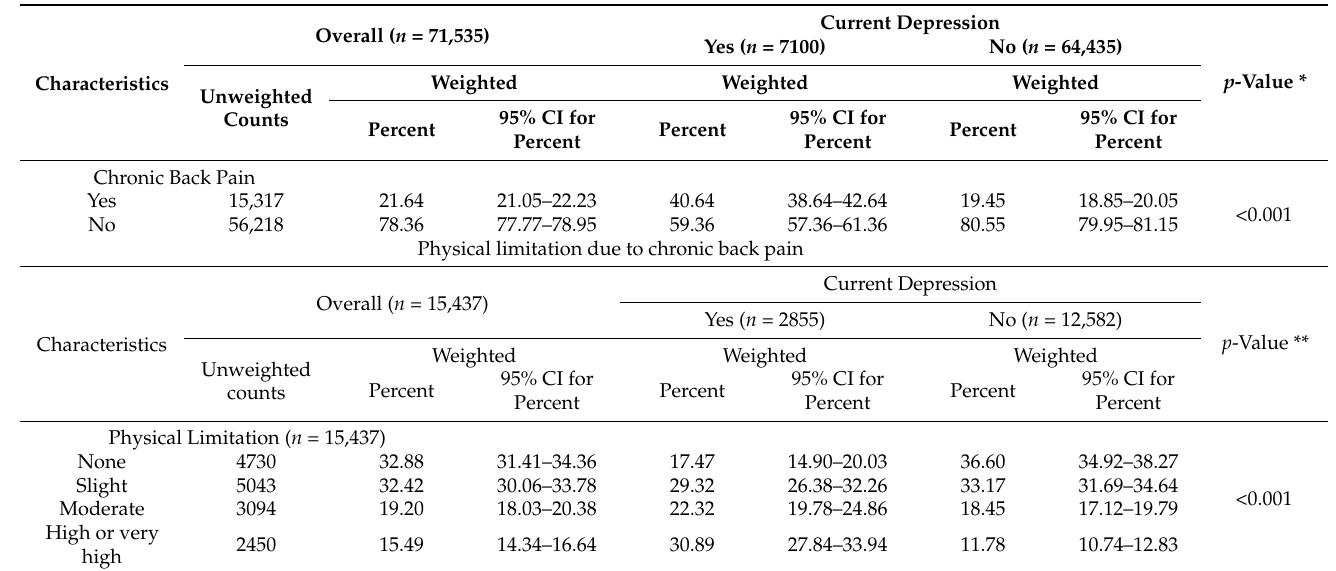
Table 2. Distribution of the exposure of interest in the final study sample. Brazilian National Health Survey, 2019.